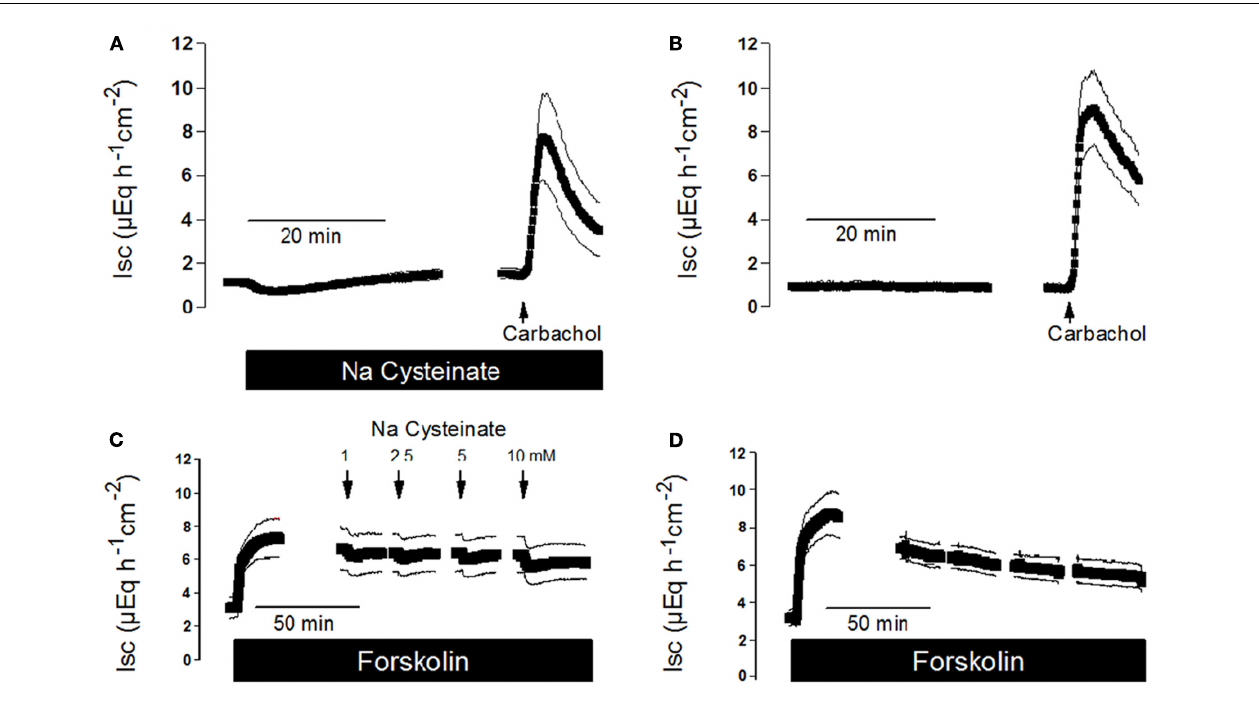
FIGURE 5 | (A) Interaction of Na cysteinate with the Isc evoked by secretagogues. Pretreatment with Na cysteinate (5 × 10 − 3 mol · l − 1 at the serosal side; black bar) slightly reduced the increase in Isc evoked by carbachol (5 × 10 − 5 mol · l − 1 at the serosal side; arrow) in mucosa–submucosa preparations of rat distal colon compared to a time-dependent control not treated with Na cysteinate (B) . (C) Na cysteinate (10 − 3 to 10 − 2 mol · l − 1 at the